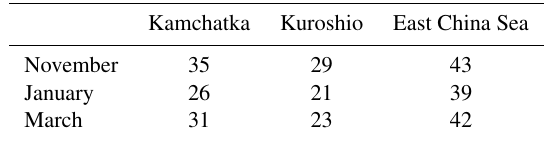
Table 3. Mean time to maximum deepening since genesis (h) of cyclones passing through the northern target region according to their genesis